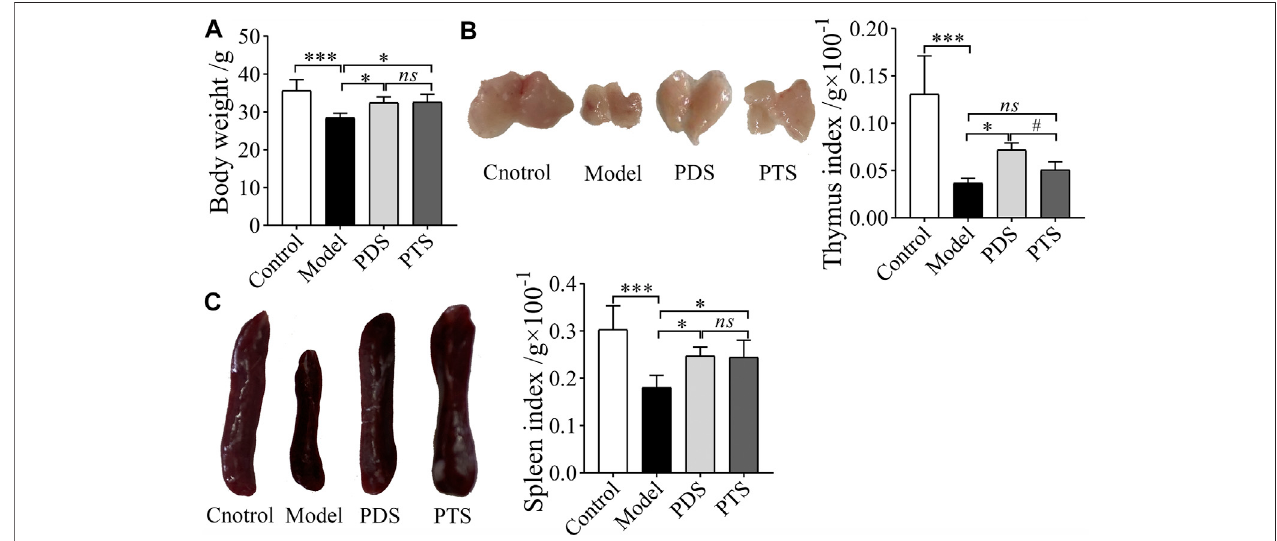
FIGURE 3 | The effects of PDS and PTS on body weight and organ indexes in myelosuppression mice. (A) Body weight; (B) Thymus index; (C) Spleen index. The data are expressedasmean±SD( n =8),* p < 0.05and*** p < 0.001comparedwiththemodelgroup; # p < 0.05comparedwithPTSgroup, ns showednosigni fi cancebetweentwogroups.